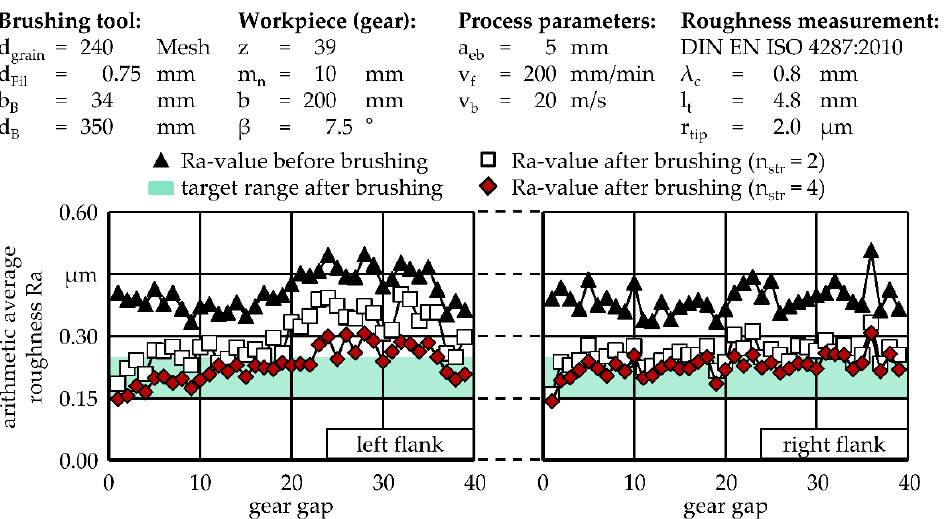
Figure 8. Comparison of the arithmetic average roughness Ra before and after the brushing process for the test series with tool specification S240x0.75 and an initial roughness of Ra ini ≅ 0.4 μ m.